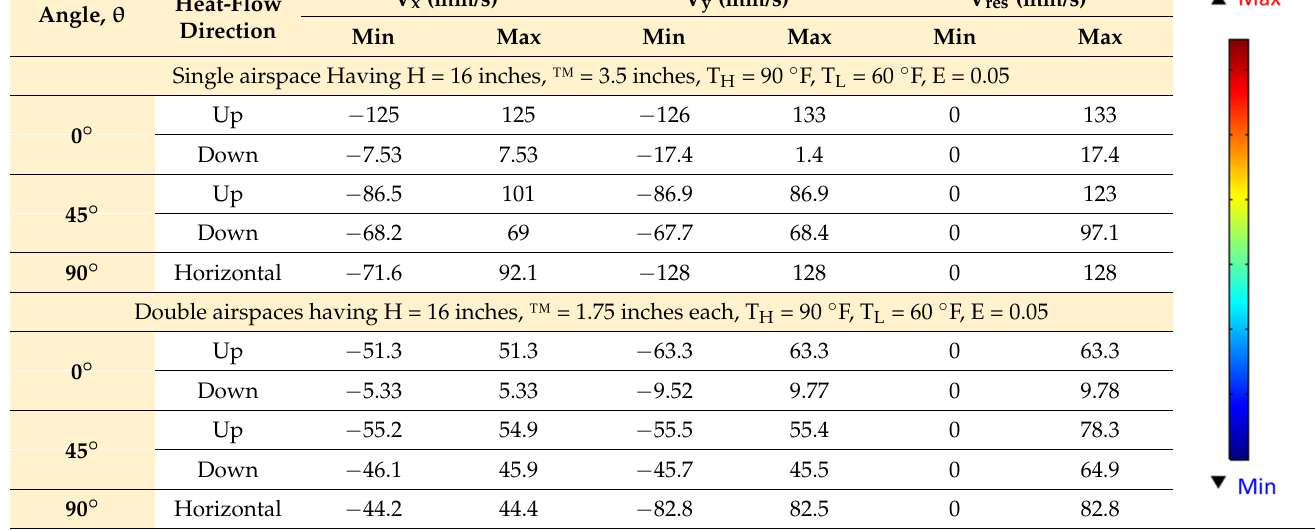
values (Min) are represented by a blue color, while the maximum values (Max) is repre- sented by a red color (Table 1, Figures 5–7). For a given airspace orientation and heat-flow direction, due to the temperature difference across the single and double airspaces, flow occurs in each space due to the density differences, creating a mono-cellular airflow or a multi-cellular airflow with multiple convective loops, as shown in Figures 4–7. Table 1. List of the ranges of contour bars (i.e., minimum value in blue color (Min) and maximum value in red color (Max) for each bar) for the contours plots of the velocity distributions inside the single and double airspaces shown in Figure 5 for horizontal velocity (V x ), Figure 6 for vertical velocity (V y ) and Figure 7 for resultant velocity (V res ). V x (mm/s) V y (mm/s) V res (mm/s) Angle,